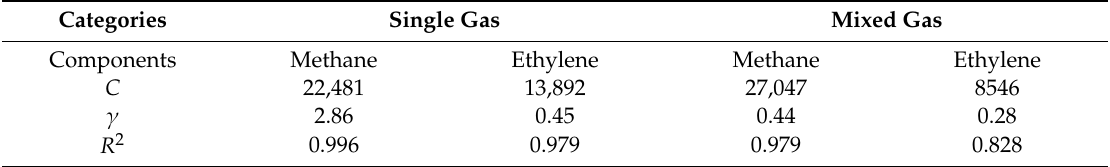
Table 4. Parameters and concentration estimation results of different categories.